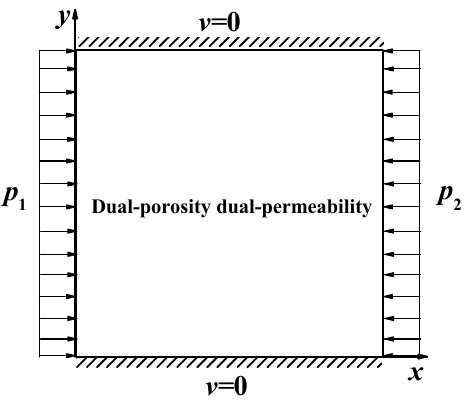
Figure 1. Computational domain and boundary condition.